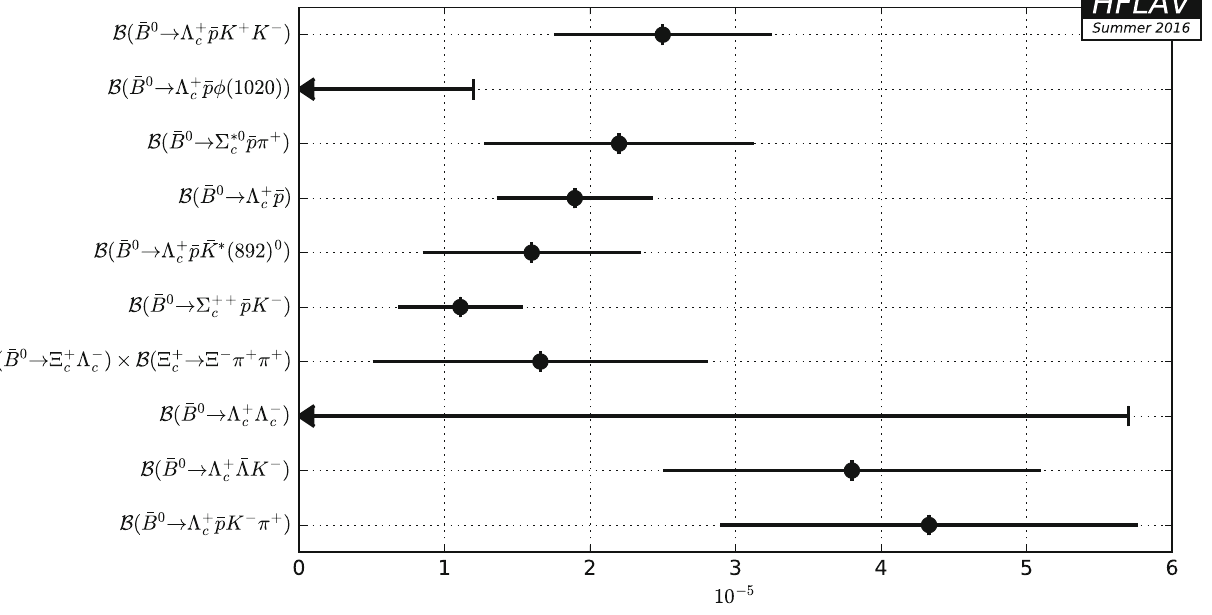
Fig. 100 Summary of the averages from Table 126